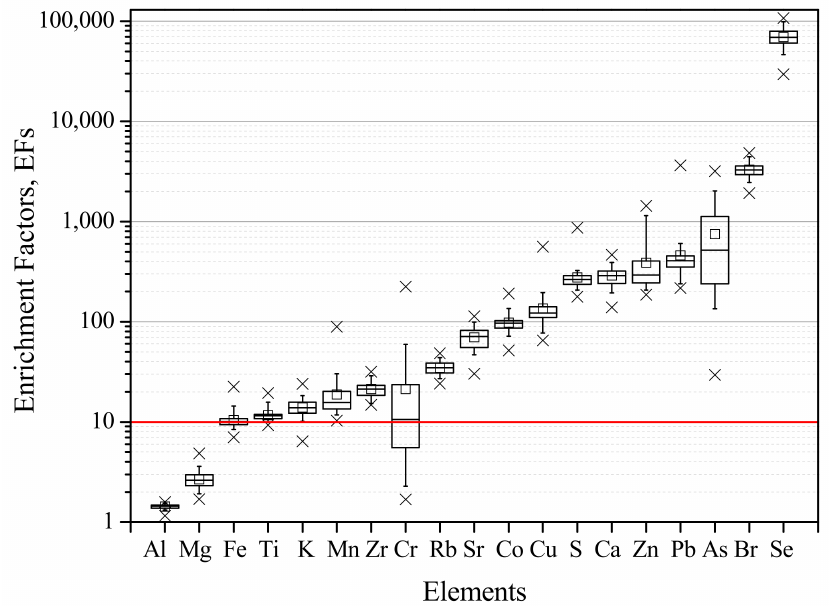
Figure 4. Mean EFs (and standard deviation) of the elements assessed in the exposed lichens. The red line represents the threshold of 10, the accepted minimum for the enrichment from a non-crustal source. Regarding the box plot, the square represents the mean, upper and lower times sign ( × ) shows the maximum and minimum values, the box provides the 25 percentile, the median and the 75% percentile, and the lower and upper minus sign ( − ) shows the 5 and 95 percentiles,